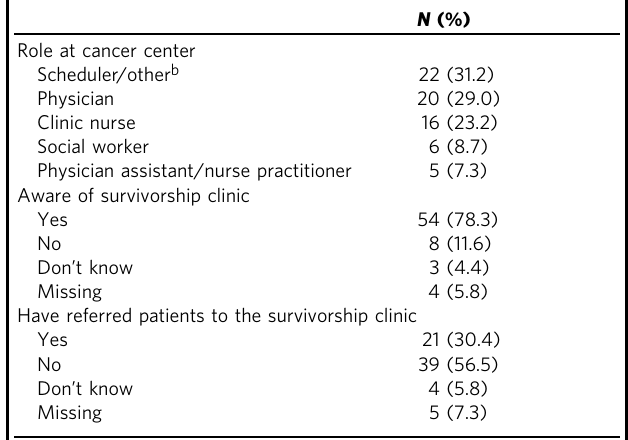
Table 1 Participant characteristics ( N = 69) a